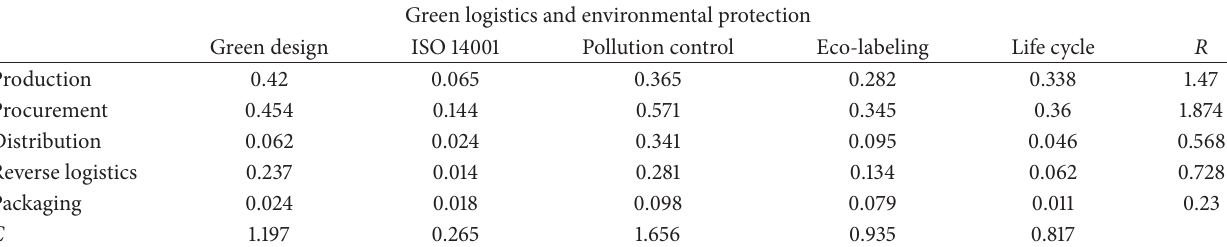
Table 2: Total-relation matrix of green logistics and environmental protection.